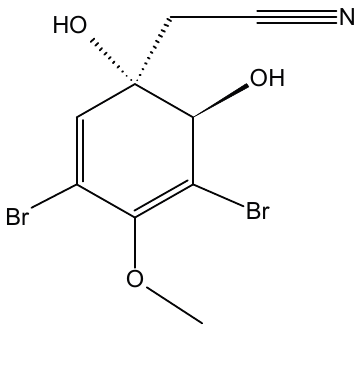
Figure 23. Aeroplysinin-1 ( 61 ).